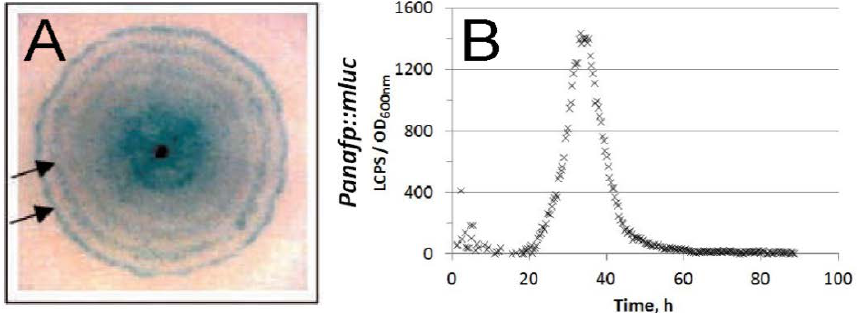
Figure 2. Expression of genes encoding antifungal peptides in aspergilli are under tight time-dependent control: ( A ) Oscillating expression of the afp gene as visualized in a 6-day old colony of an A. giganteus reporter strain. Here, the reporter gene β -glucuronidase ( uidA ) was put under control of the afp promoter. Induction of P afp::uidA reporter expression results in blue color formation on agar plates in a circadian manner (indicated by arrows). Blue color formation is visible only in the vegetative medium and occurs when A. giganteus vegetative hyphae achieve the competence to form aerial hyphae/conidiophores. Picture is reproduced from [17] with permission from Springer Nature. ( B ) Luciferase expression under control of the anafp promoter was measured using the reporter strain PK2.9 (P anafp::luc ). Reporter activity was measured as luminescent counts per second normalized to culture optical density during 4 days of submerged cultivation of strain PK2.9 in microtiter plates. Picture is taken from [10], licensed under CC-BY 4.0. LCPS, luminescent counts per second.